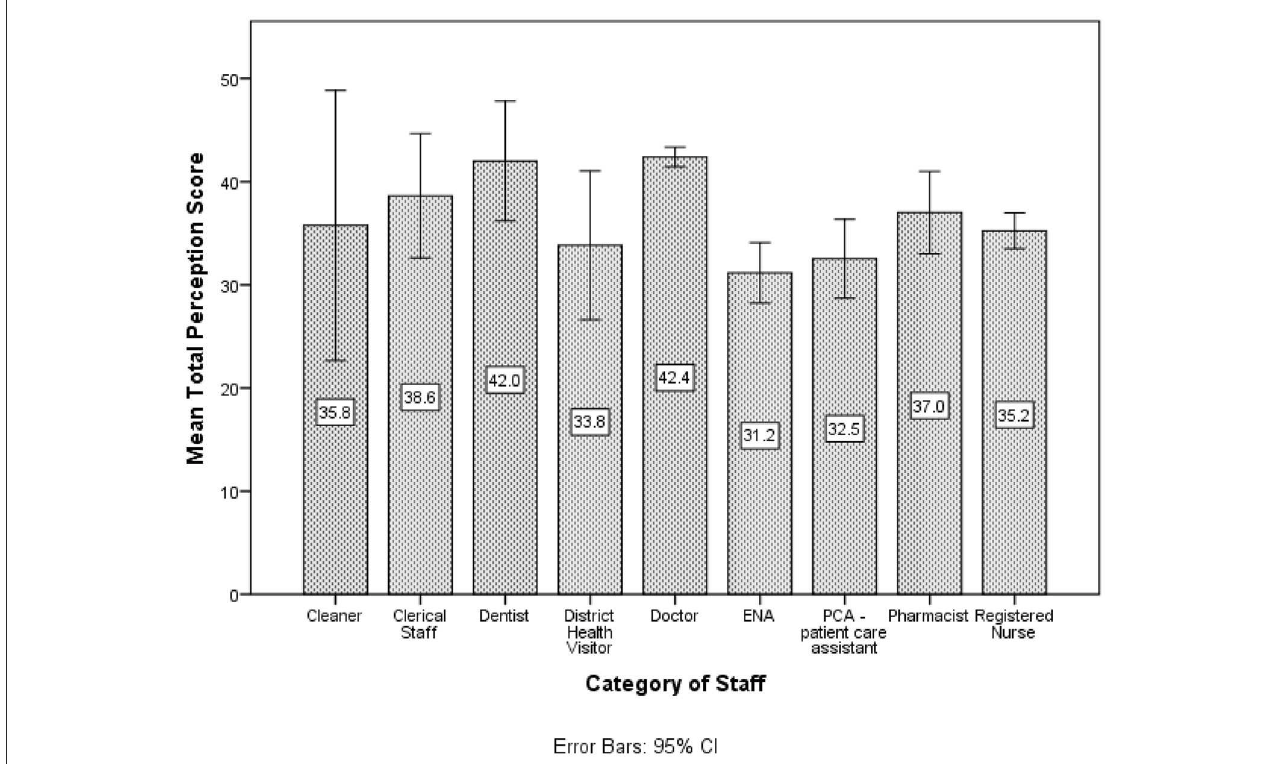
FIGURE4 Participants’ mean perception score toward the AstraZeneca vaccine by category of